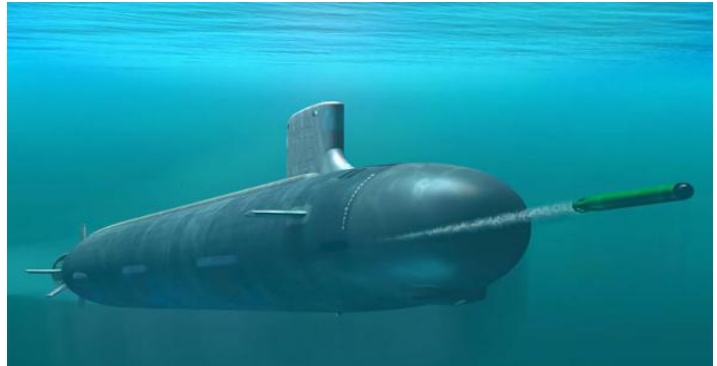
Figure 1. The torpedo attack